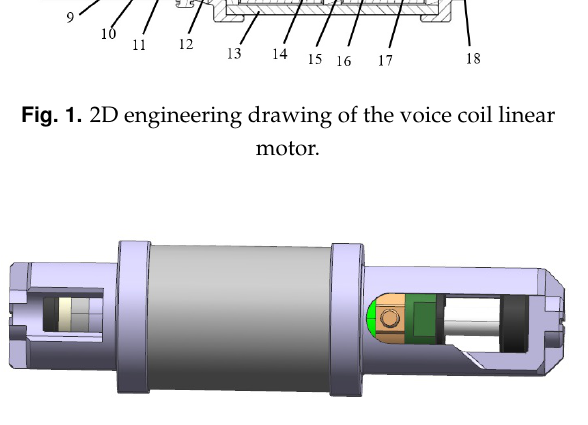
Fig. 2. 3D structure diagram of the voice coil linear